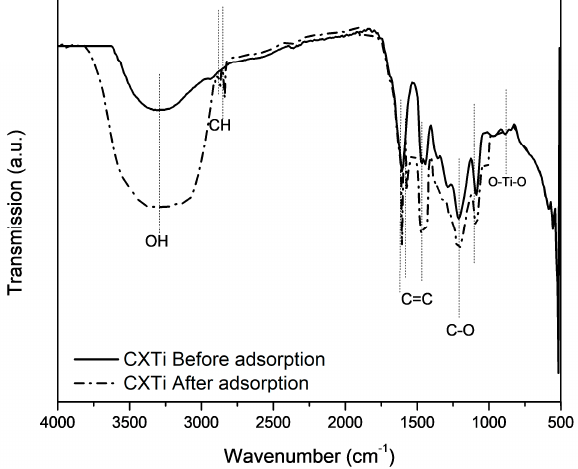
Figure 7. FTIR spectra of CXTi recorded before and after the adsorption treatment.